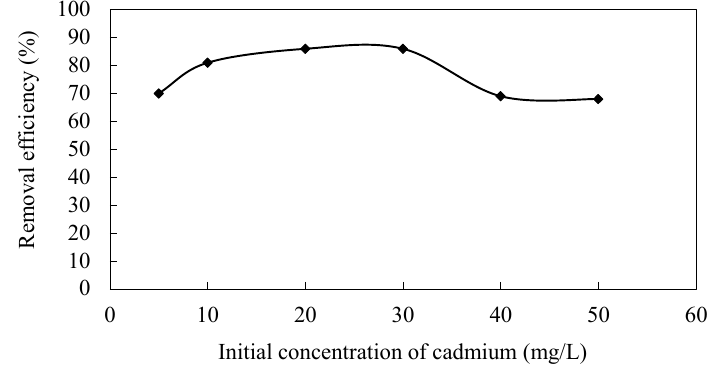
Fig. 8. The effect of initial Cd 2+ concentration on the removal efficiency of Cd 2+ by the